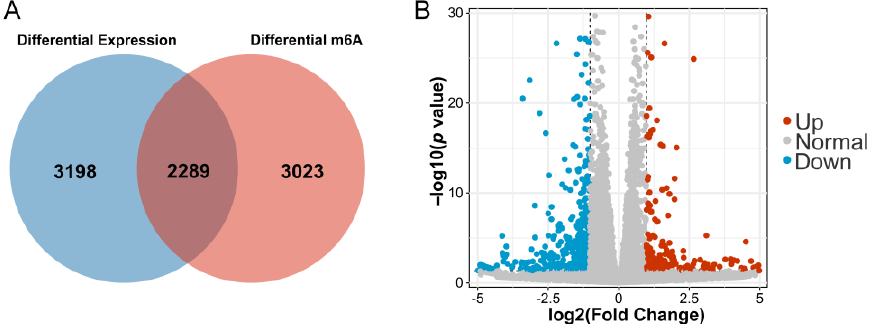
Figure 3. ( A ) DEGs and differentially m6A-modified mRNAs between cells with or without AFB1 treatment; ( B ) the volcano plot of 680 DEGs.